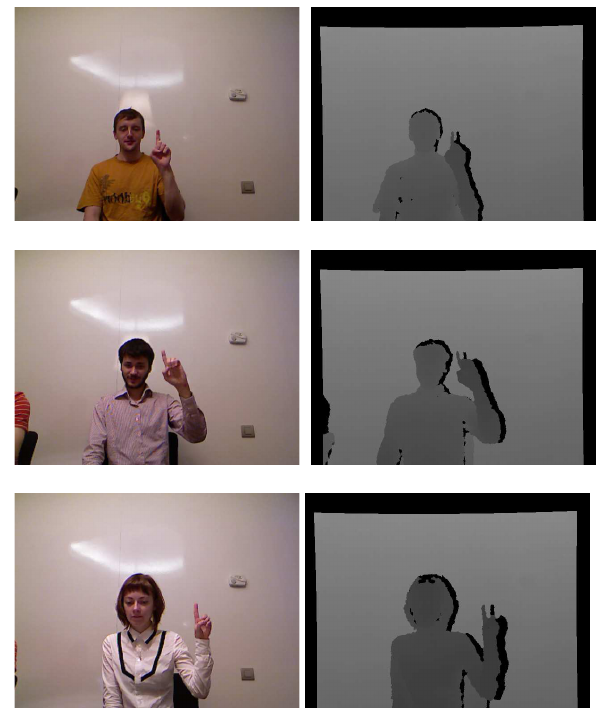
Figure 8: Gesture base, sign D